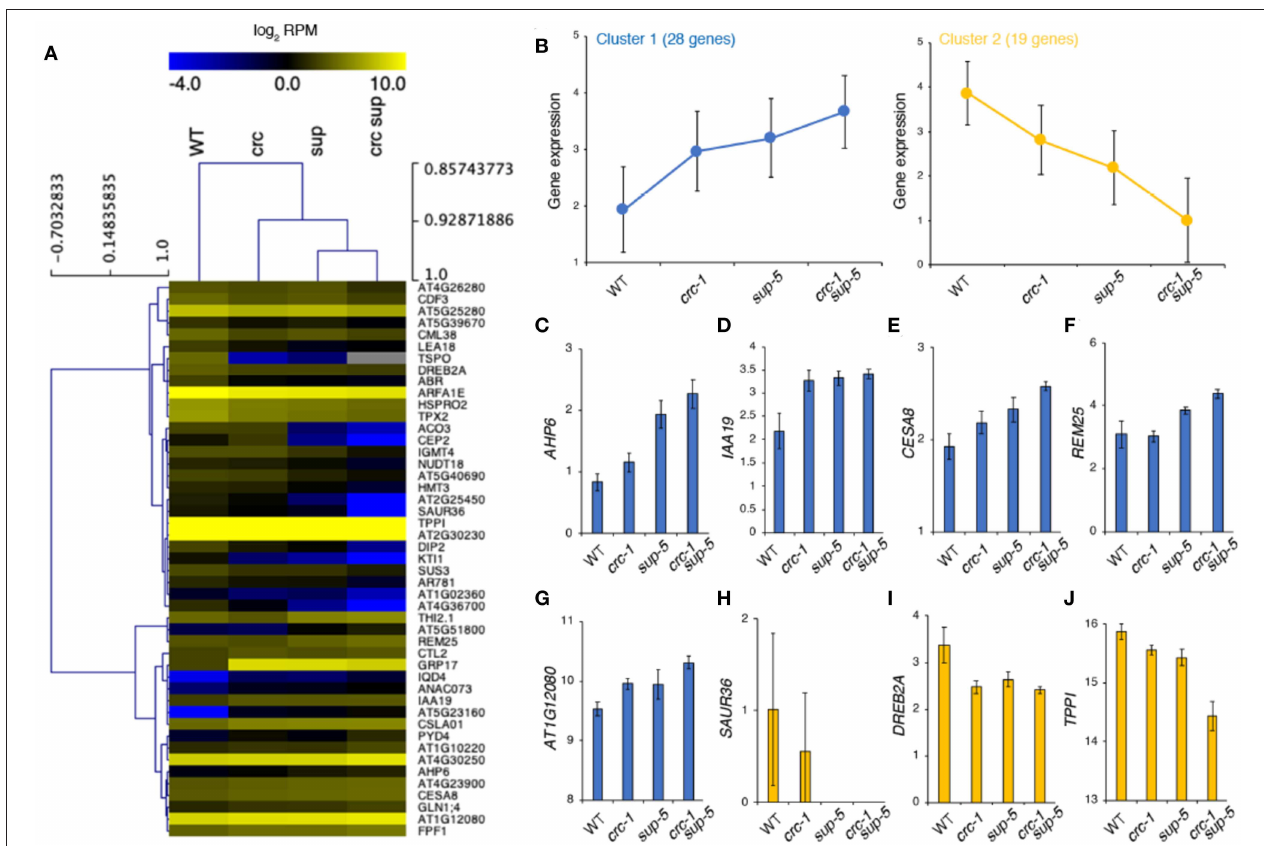
FIGURE 6 | Clustering of high-confidence downstream targets regulated by CRC and SUP. (A) Clustering of 47 genes during stamen formation. (B) Gene expression from two different clusters: cluster 1 (left) and cluster 2 (right). (C–J) Expression level of genes according to RNA-seq. AHP6 (C) , IAA19 (D) , CESA8 (E) , REM25 (F) , AT1G12080 (G) , SAUR36 (H) , DREB2A (I) , and TPPI (J) . Mean ± SEM (log 2 of reads per million mapped reads [RPM]) are